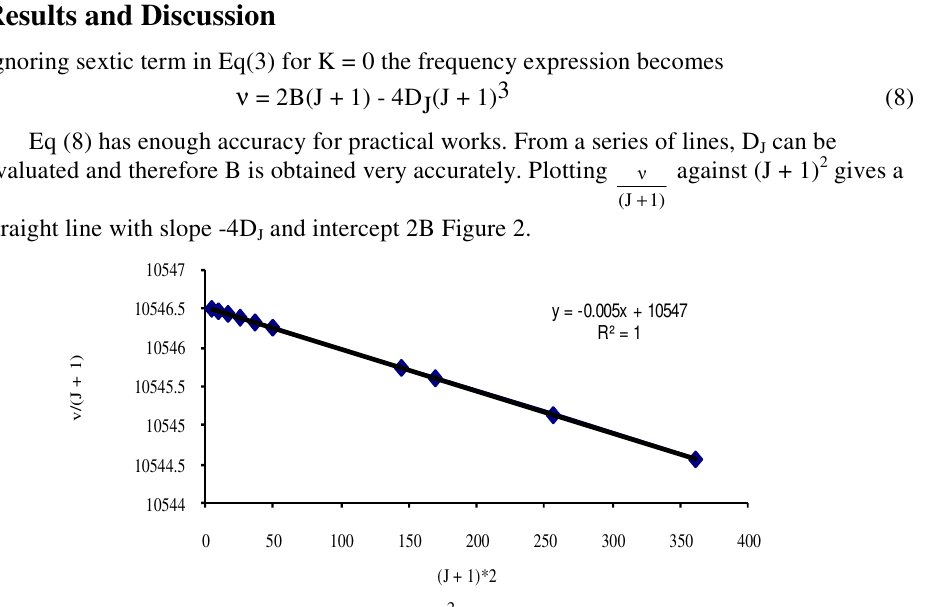
Figure 2. Diagram of v/(J + 1) against (J + 1) 2 for trioxane for ground state, from J = 0 to J = 19. Abbreviation of equation Eq(3) gives